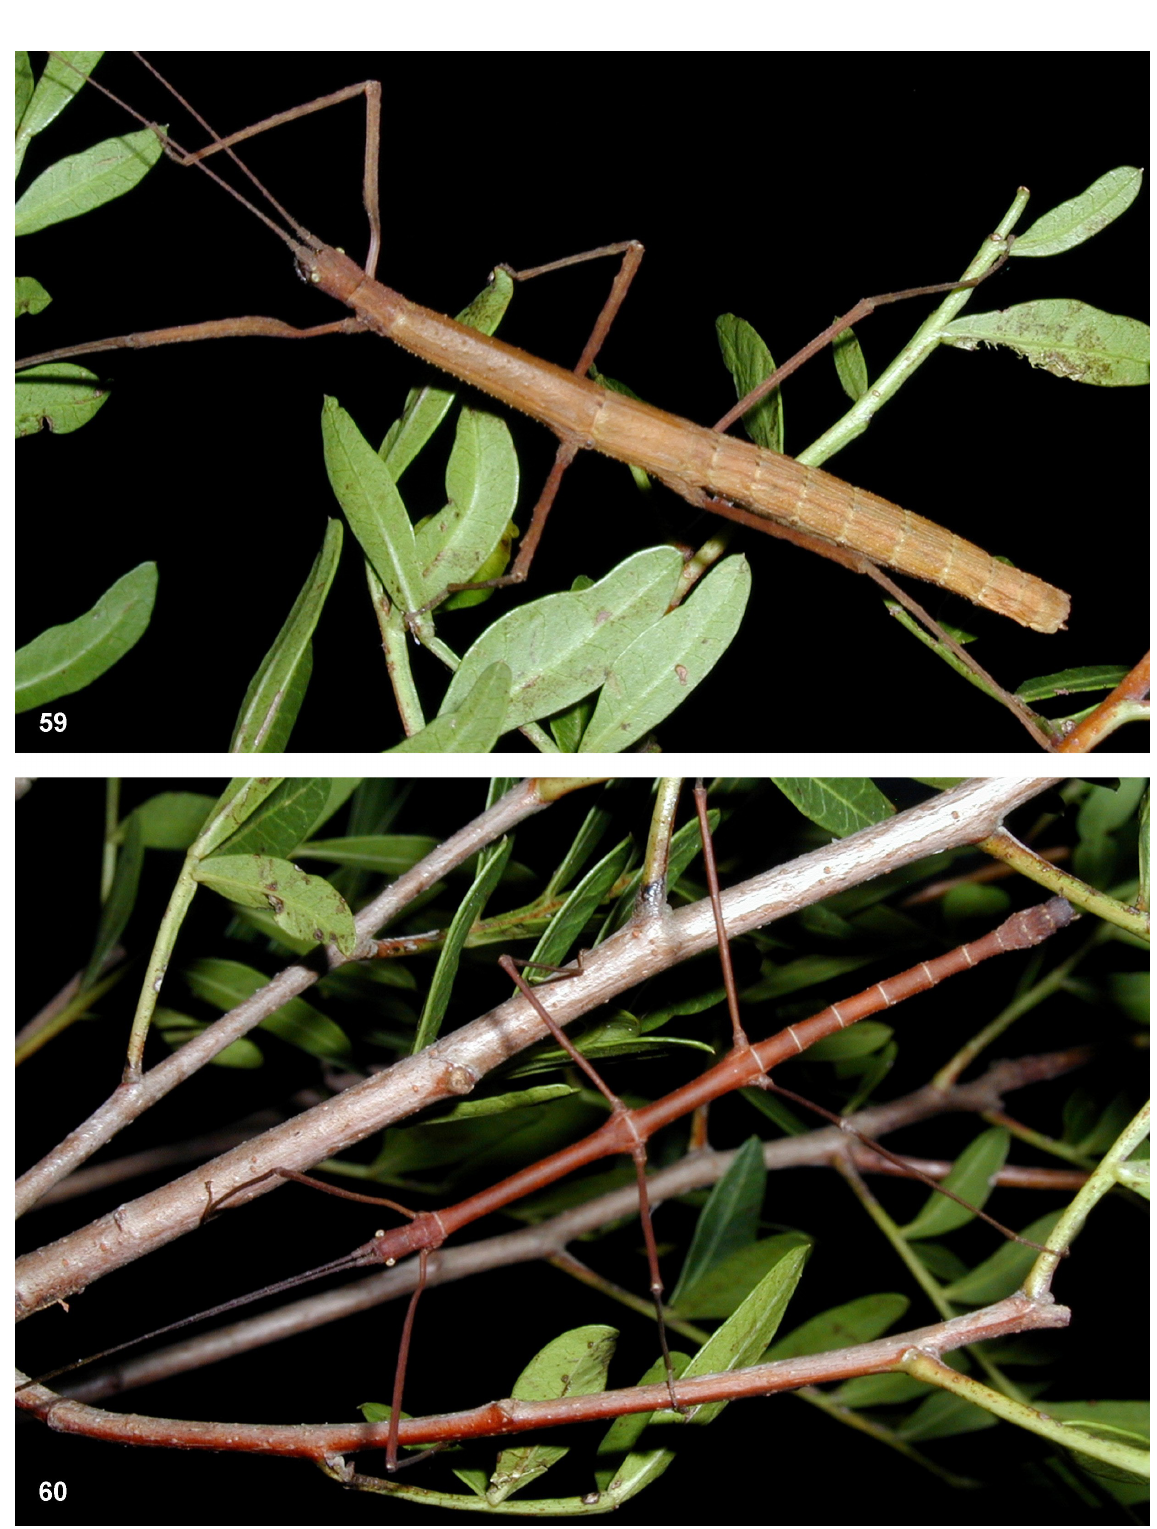
Figs 59–60. Lobolibethra pozuzoae sp. nov. 59. Live ♀, PT (FH). 60. Live ♂, PT